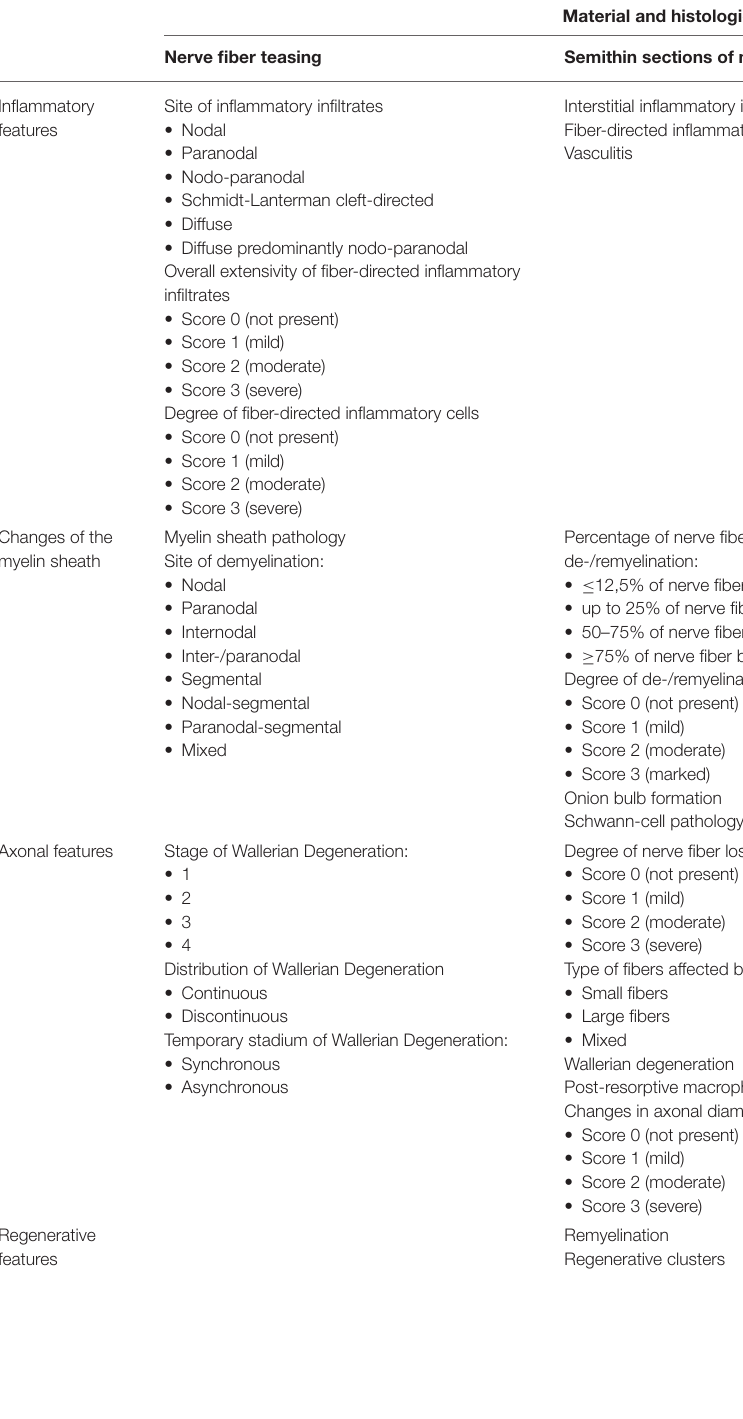
TABLE 1 | Morphologic criteria applied for histological